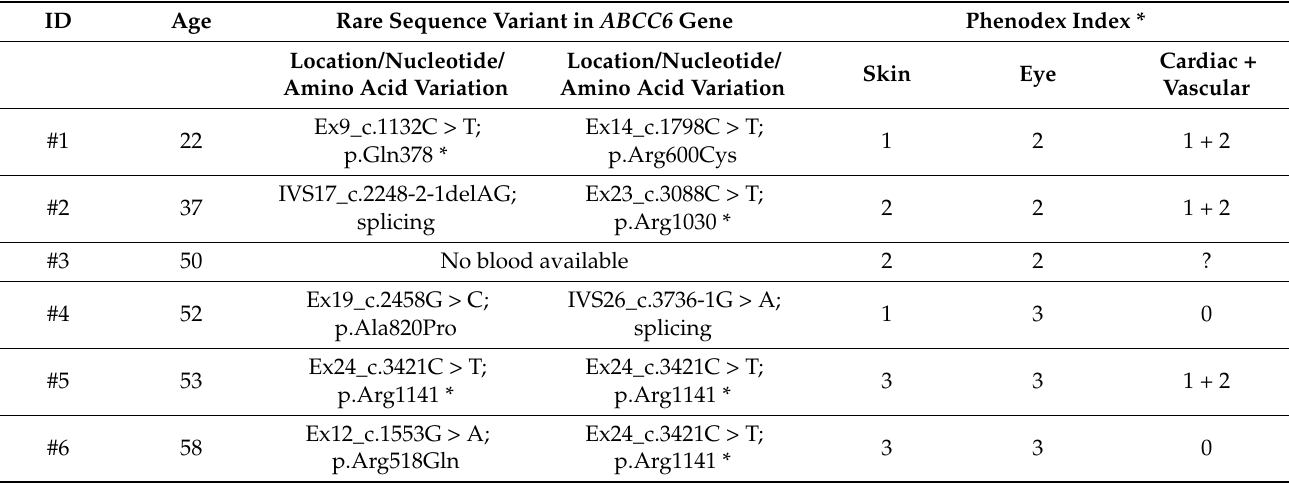
Table 1. Clinical data of PXE patients (ID) based on Phenodex index and ABCC6 causative